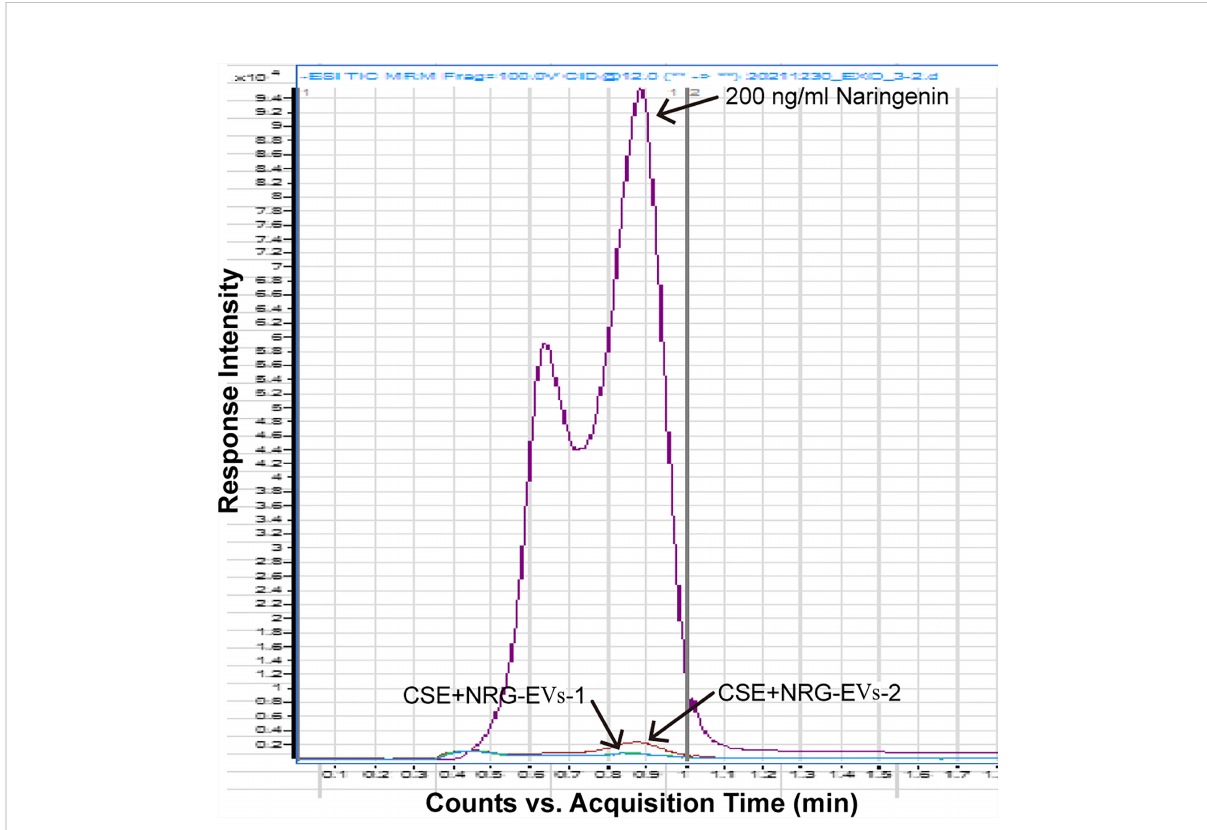
FIGURE 2 Detection of naringenin in CSE+NRG-EVs by high-performance liquid chromatography with tandem mass